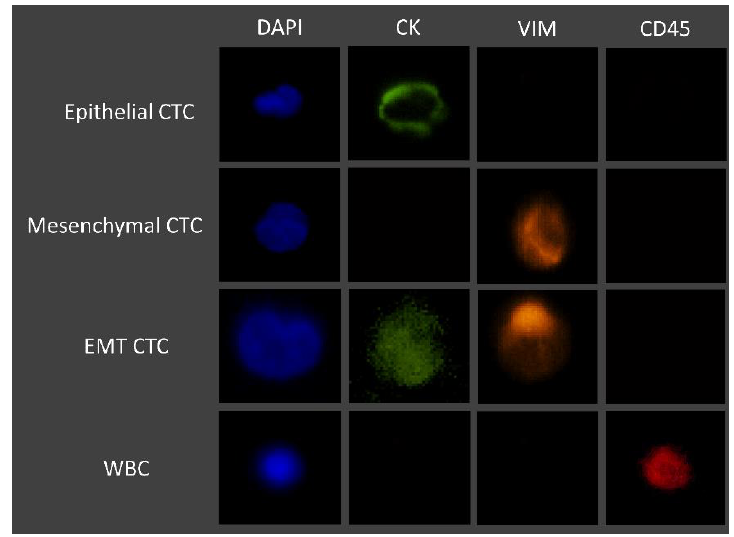
Figure 3. Immunofluorescence staining characteristics for the identification of CTCs.